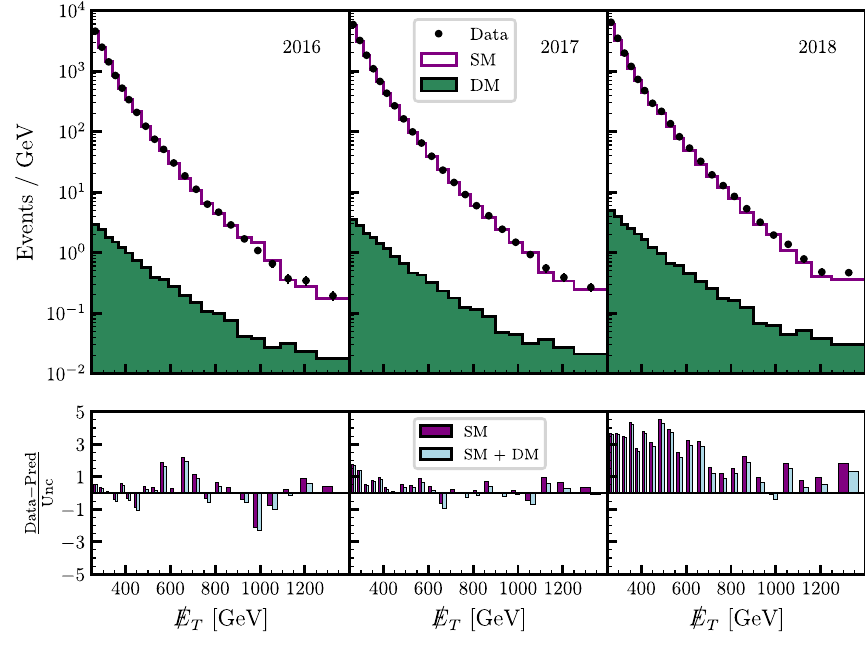
lihood is either uncapped (left), or capped to prevent preference over the Standard Model (right). 1 σ and 2 σ contours are shown in white and grey respectively